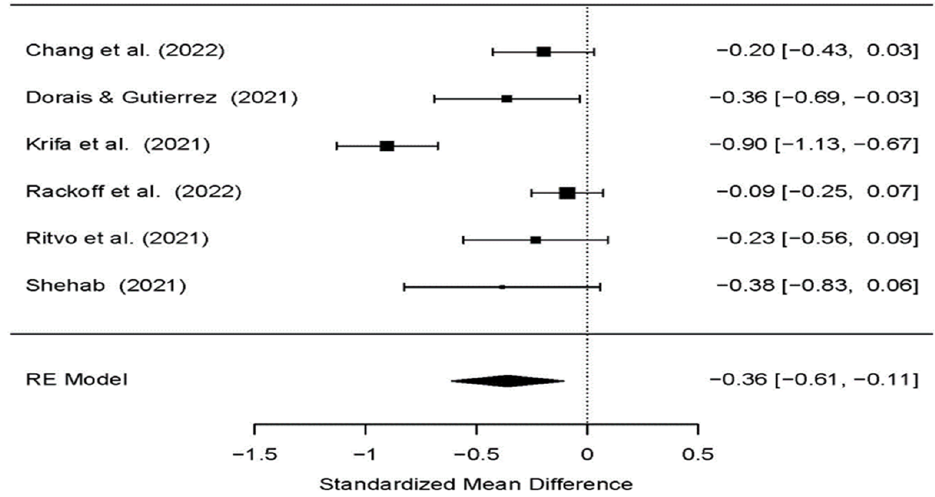
Figure 2. The effects of psychological interventions on reducing stress among university students during COVID-19 in the included randomized controlled trials [32–36,41].